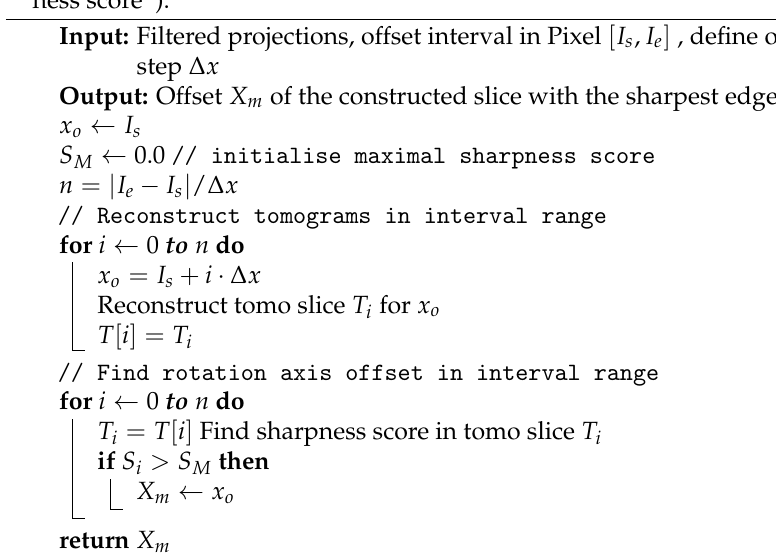
Algorithm 5: X m Find shift of rotation axis (uses Algorithm 4 “Determine sharp- ness